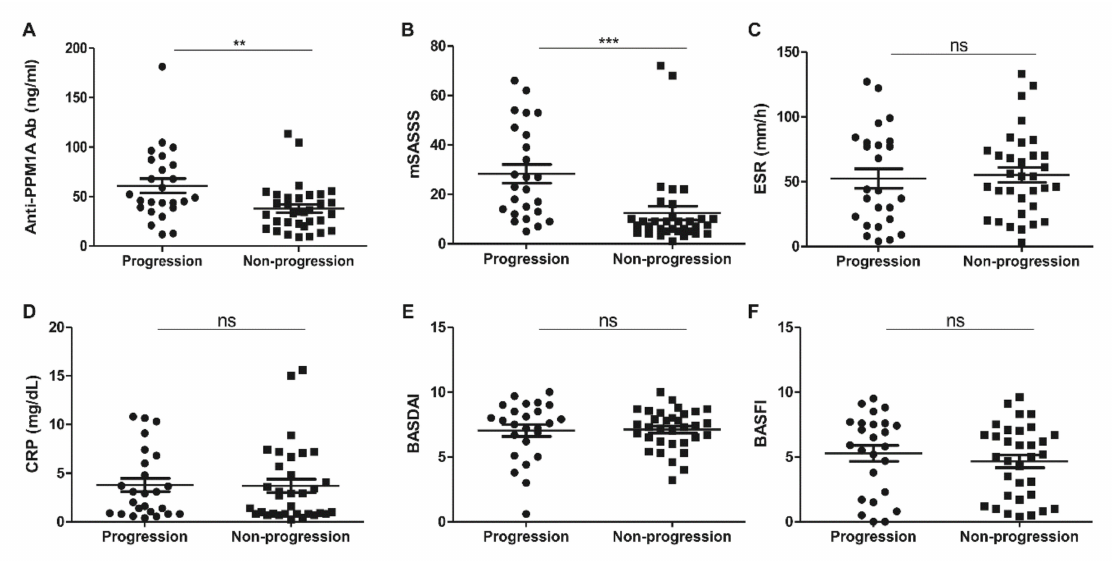
Figure 1. ( A ) Anti-PPM1A antibodies, ( B ) mSASSS, ( C ) ESR, ( D ) CRP, ( E ) BASDAI, and ( F ) BASFI at baseline in patients with radiographic progression consequently. PPM1A: Protein phosphatase magnesium-dependent 1A, mSASSS: Modified Stoke Ankylosing Spondylitis Spinal Score, ESR: Erythrocyte Sedimentation Rate, CRP: C-reactive protein, BASDAI: Bath Ankylosing Spondylitis Disease Activity Index, BASFI: Bath Ankylosing Spondylitis Functional Index. ** p < 0.01, *** p < 0.001, ns: Not